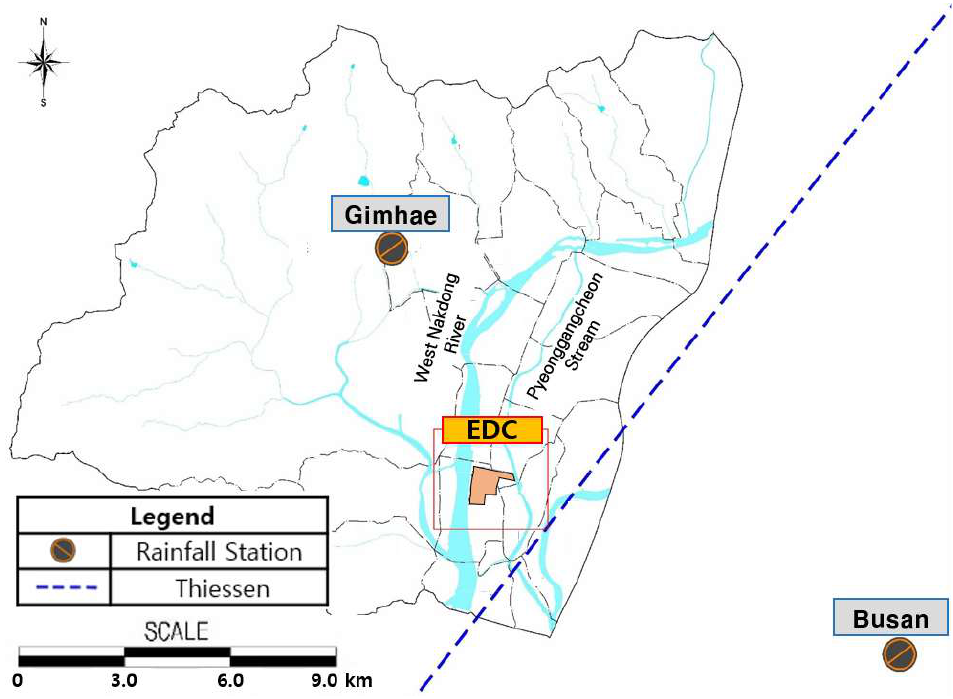
Figure 2. Selection of rainfall station.